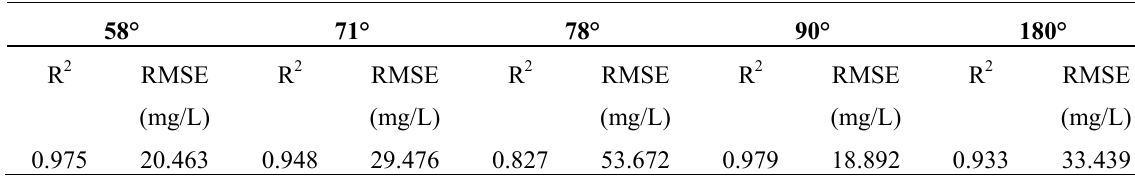
Table 2. Correlation Coefficient (R 2 ) and Root Mean Square Error (RMSE) for Different Angle of Scattering Light